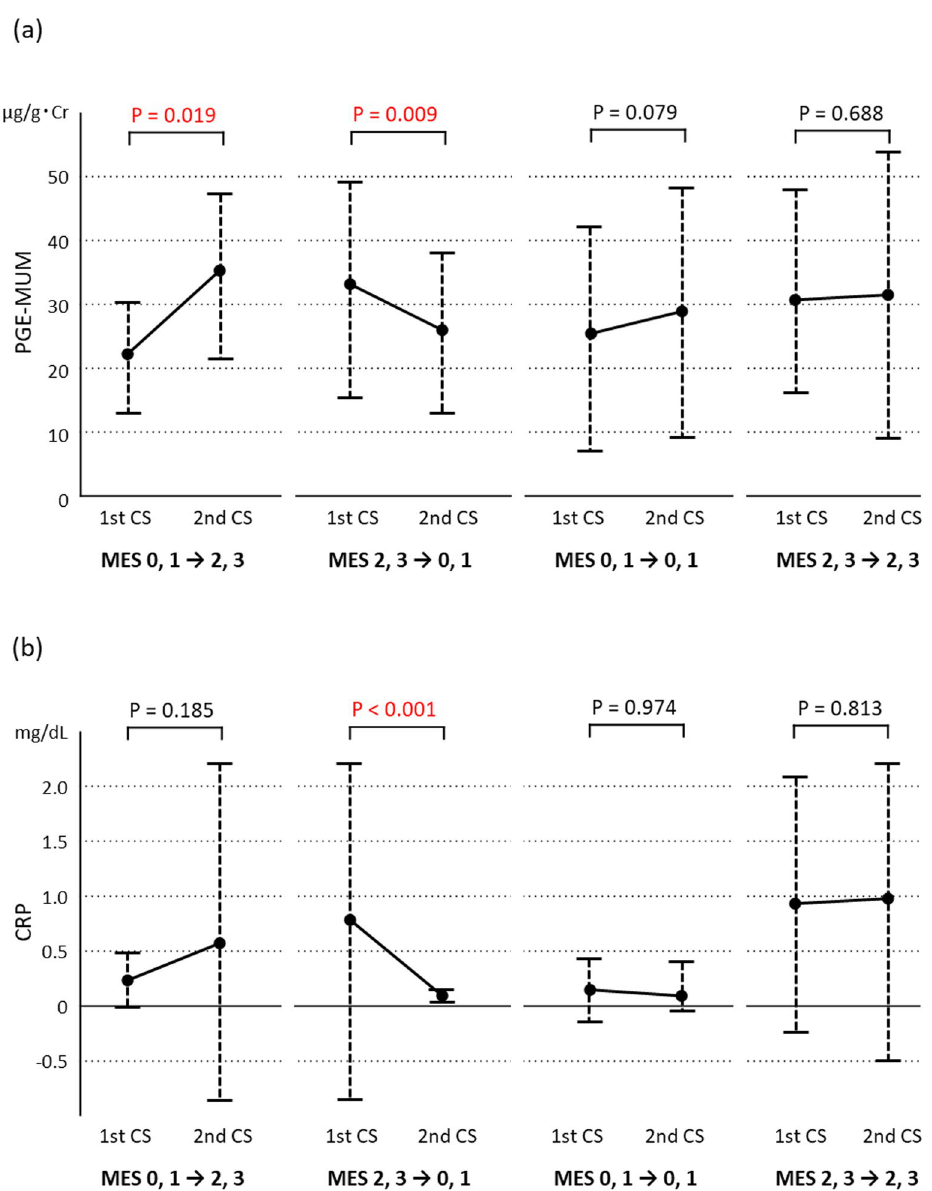
Figure 2. Varying levels of prostaglandin E-major urinary metabolite (PGE-MUM) ( a ) and C-reactive protein (CRP) ( b ) in the Cohort 2 subgroups, which reflected changes in MES scores, from the precedent colonoscopy (first CS) to the subsequent (second